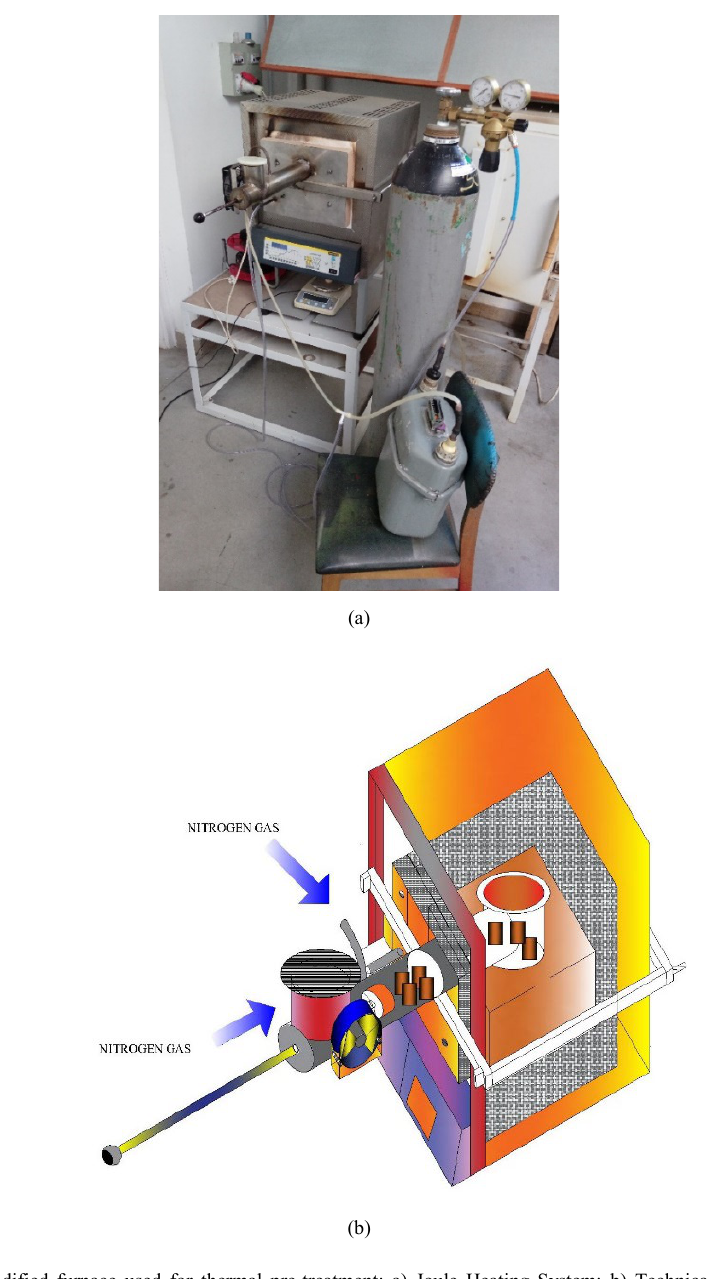
Fig. 3. The modified furnace used for thermal pre-treatment: a) Joule Heating System; b) Technical drawing of the torrefaction